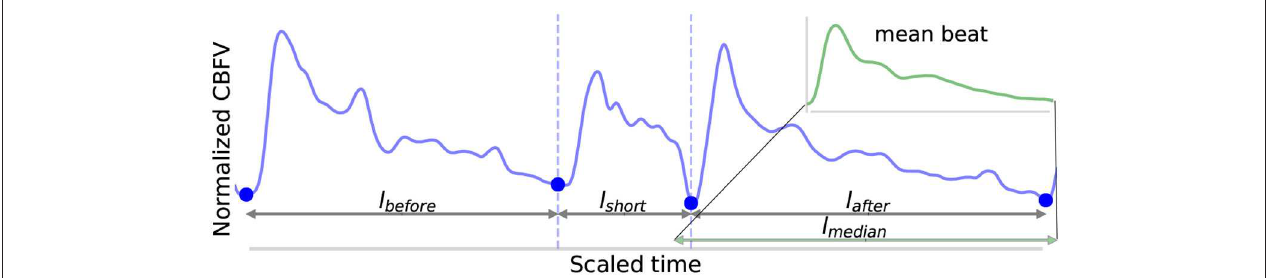
FIGURE 5 | Shown above is an example of the detection of a short beat. The short beat is shown in the main figure between the dashed vertical lines between its two neighboring beats. Detected onsets are marked by blue dots. The lengths l before , l short , and l after are also labeled. The mean beat calculated for this scan is also displayed in the subfigure shown in the upper right corner (not to scale), and its length l median is displayed correctly to scale alongside the other distances in the main figure. The x (time) and y (CBFV/MDF amplitude) axes have been normalized to dimensionless